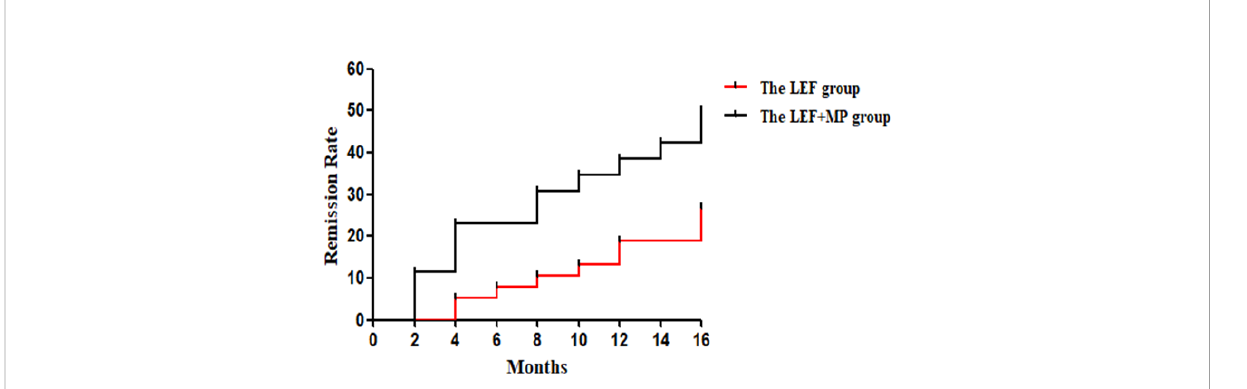
FIGURE 3 The log-rank test in the LEF group and the LEF+MP group. Compared with the LEF group, the LEF+MP group had a higher remission rate (log- rank, p < 0.05) (Figure 3).